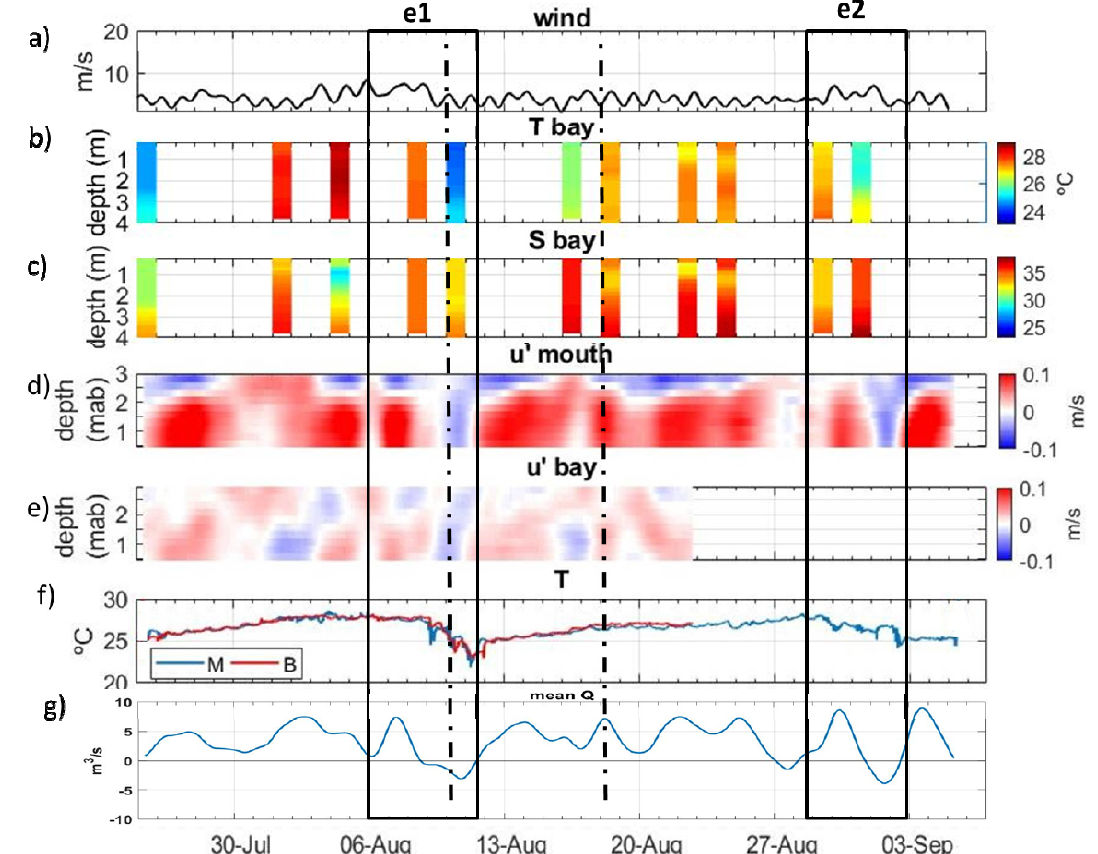
Figure 8. From top to bottom, wind speed ( a ), time series of temperature at a central point of the bay ( b ), time series of salinity at a central point of the bay ( c ), alongshore currents in mouth ( d ), alongshore currents in the bay ( e ), and bottom temperature ( f ) in mouth (blue) and bay (red), mean flow (positive inflow) in the mouth ( g ). The black boxes show the NW events. The dotted lines mark the days of the vertical sections shown in Figure 10.